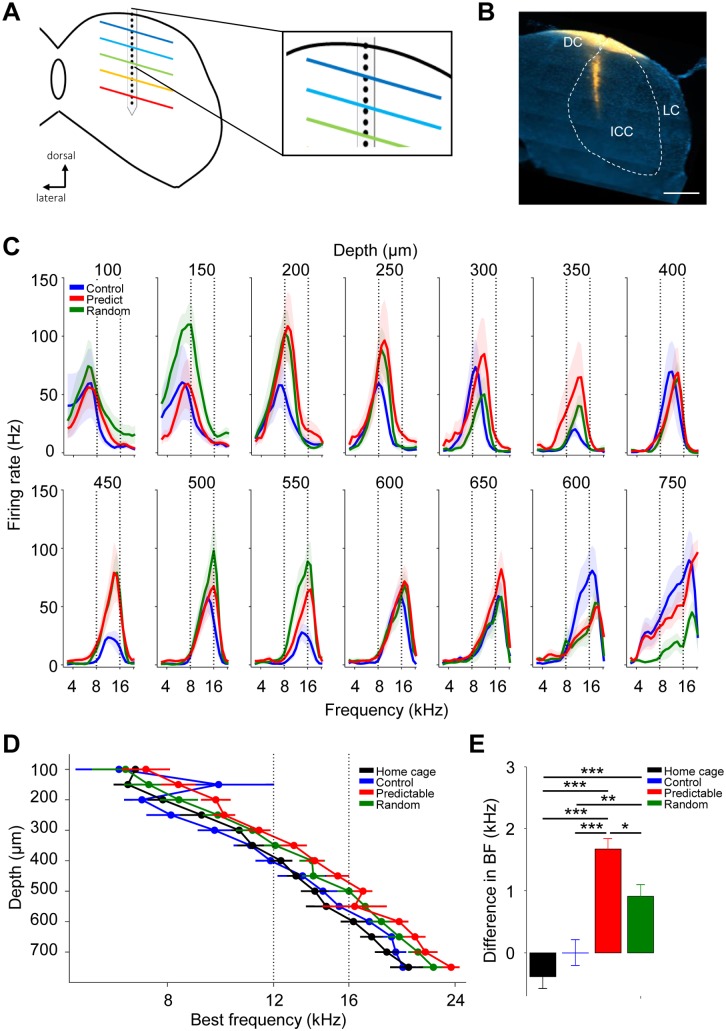
Sound exposure results in increases in response gain in the inferior
colliculus.(A) Left, schematic representation of the recording approach in the
inferior colliculus using linear multielectrode array. Inset: Schematic
representation of positioning of most superficial recording site,
aligned with dura. (B) Right, representative dorsoventral electrode
penetration track (DiI) through dorsal cortex and central nucleus. “DC”:
dorsal cortex; “ICC”: central nucleus; “LC”: lateral cortex. Scale bar
500 μm. (C) Mean tuning curves of simultaneously recorded evoked
responses (70 dB) for different depths in the inferior colliculus
(linear mixed effects model; group × depth interaction
F2,8412 = 4.21, p < 0.05). Animals
and recording sites: control n = 10 and 98; predictable
n = 14 and 162; and random n = 7
and 91. (D) Mean collicular BF for different depths in the inferior
colliculus (ANOVA, group F3,334 = 10.89; p
< 0.0001). Animals and recording sites for D-E: home cage
n = 6 and 72; control n = 10 and
98; predictable n = 14 and 162; and random
n = 7 and 91. (E) Mean BF difference across the
tonotopic axis with respect to the mean BF of control group (ANOVA,
group F3,386 = 9.97, p < 0.0001.
Corrected pair comparisons: *p < 0.05,
**p < 0.01, ***p < 0.001).
Error bars represent SEM. Numerical data for this figure can be found in
S1
Data. BF, best frequency; DiI,
1,1'-dioactedecyl-3,3,3,3'-tethramethyl indocarbocyanide.